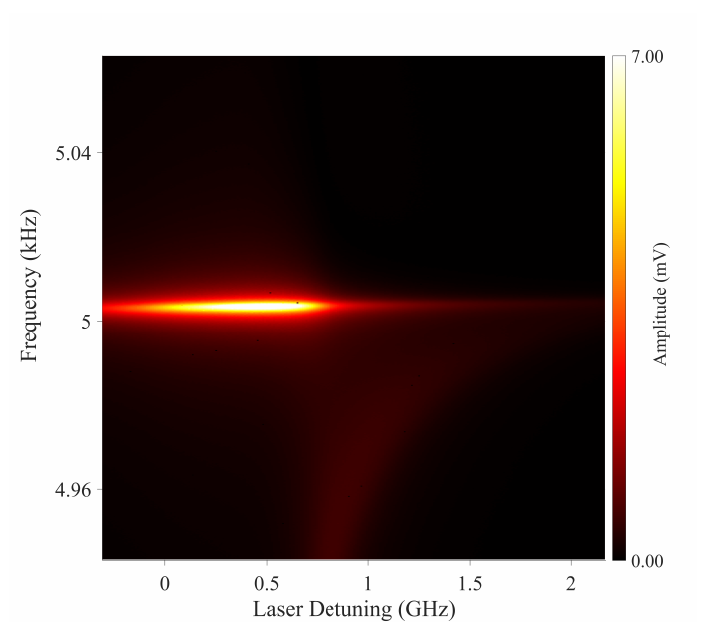
Figure 6. Dependence of the rf signal amplitude on the probe beam detuning from the 6 2 S 1/2 F = 3 → 6 2 P 3/2 F’ = 2 transition. The measurements were made with a pump beam power of 1.17mW and probe beam power of